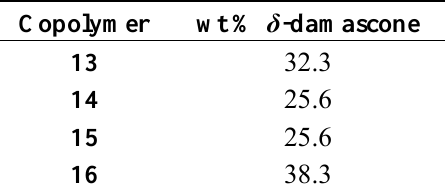
Table 3. Loading of δ -damascone in conjugates 13 – 16 as determined by 1 H-NMR spectroscopy.